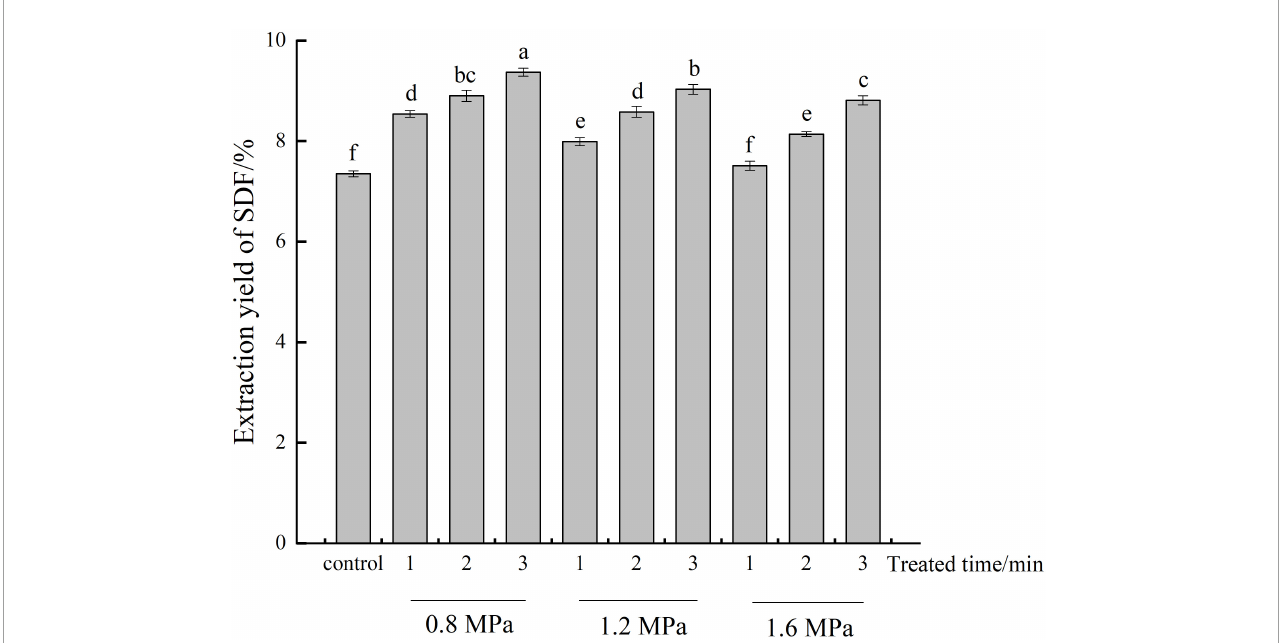
FIGURE1 Extraction yields of soluble dietary fiber (SDF) at different steam explosion (SE) treatment conditions. Control: untreated adlay bran; adlay bran treated by SE at different steam pressures (0.8, 1.2, and 1.6 MPa) and different residence times (1, 2, and 3 min). Different lowercase letters over column indicate significant differences ( p < 0.05).